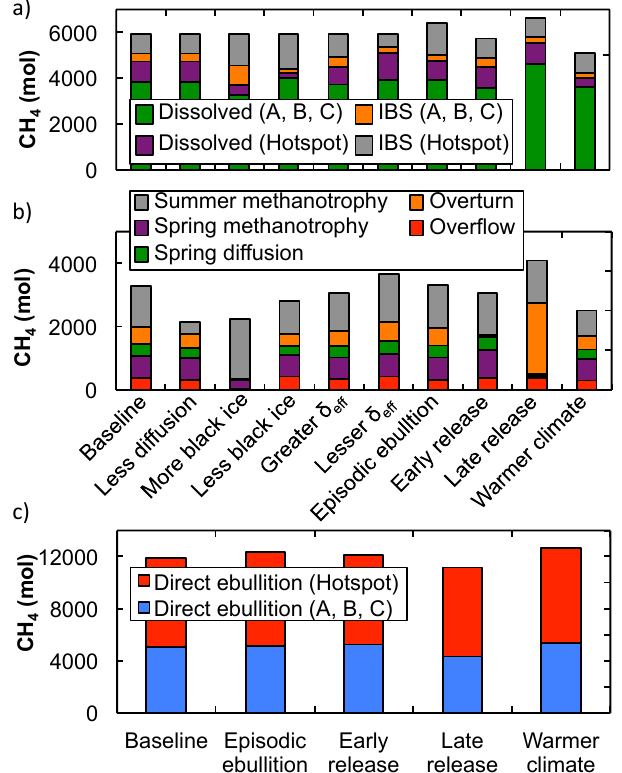
Figure A1. Mean yearly quantities of CH 4 involved in various pro- cesses in the model, as calculated by the versions of the model de- scribed in Sects. 3.4 and 3.5 and Table 1. The magnitude of win- ter methanotrophy is constant among all versions because it is lim- ited by the amount of O 2 dissolved in the water column at the time of freeze-up. The magnitude of summer diffusion emissions is also constant because it is calculated from measurements of surface CH 4